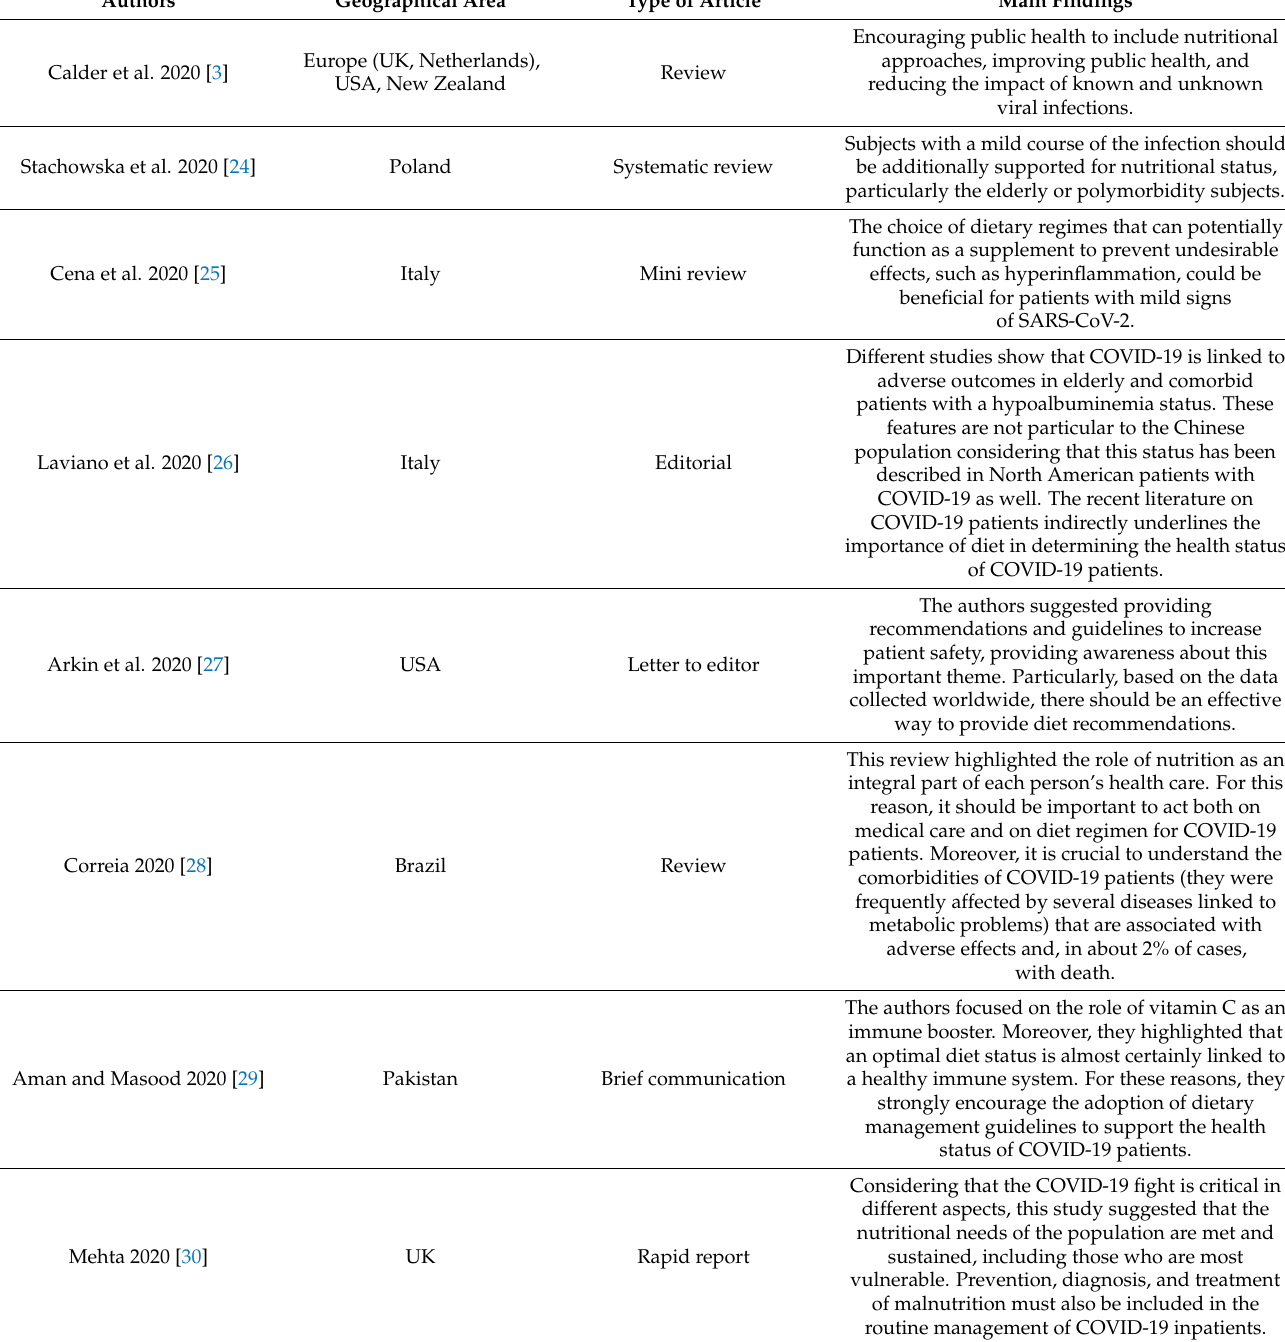
Table 1. The selected articles analyzed in this review with the relative main findings are